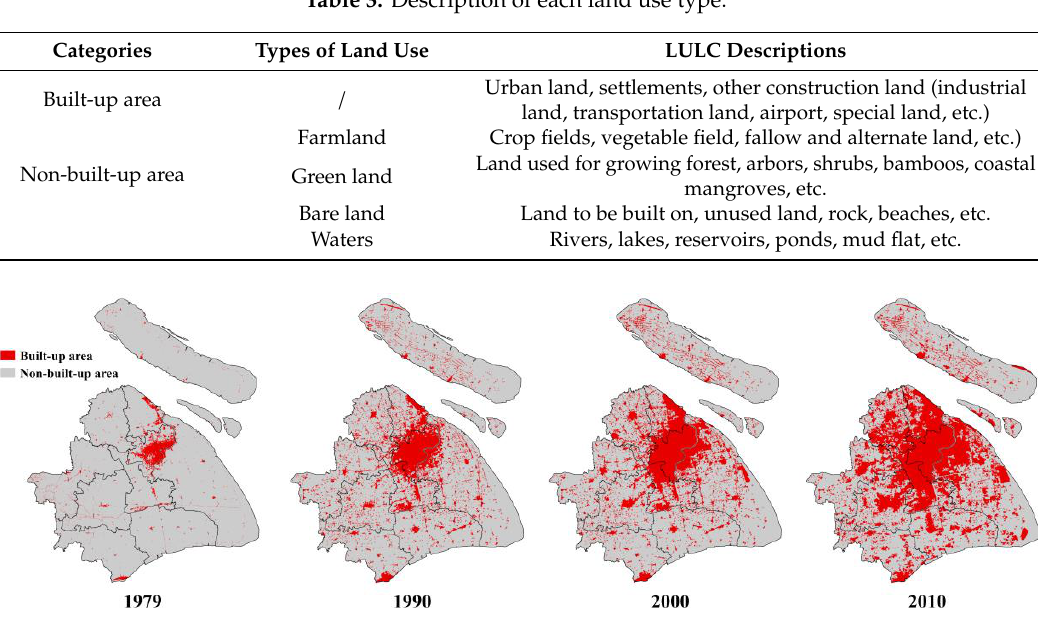
Table 3. Description of each land use type.